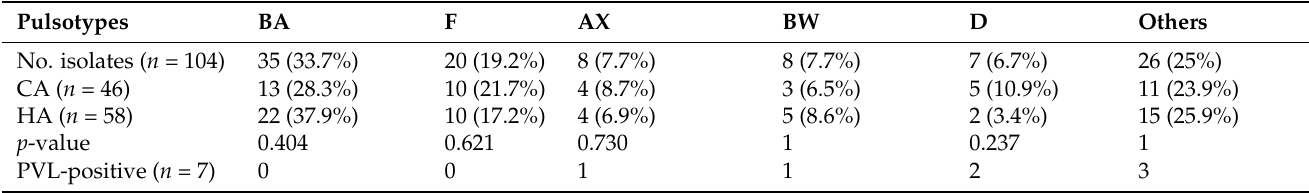
Table 3. Molecular characteristics of 104 methicillin-susceptible Staphylococcus aureus ocular isolates stratified by pulsotype.